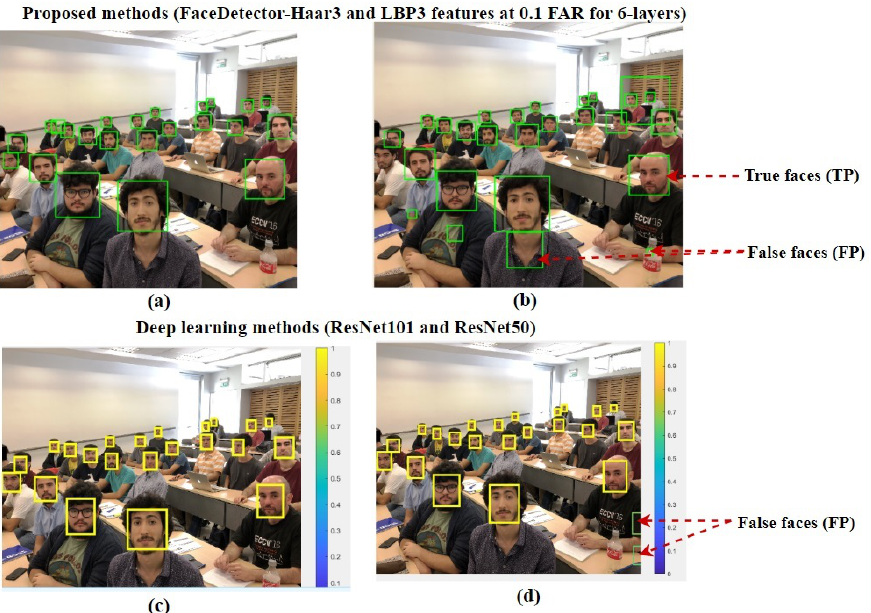
Figure 8. Faces detected by ( a ) Haar-like and ( b ) LBP custom face detector at 0.1 FAR for 6-layers of cascade stages. Subimages ( c , d ) are the output from ResNet101 and ResNet50, respectively.